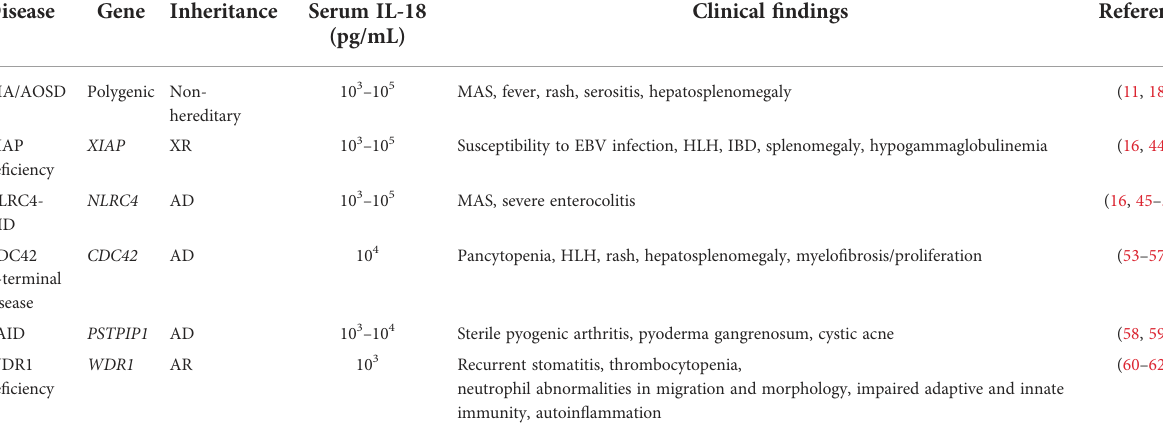
TABLE 1 Immune-mediated in fl ammatory diseases with massive and chronic elevation of serum IL-18.